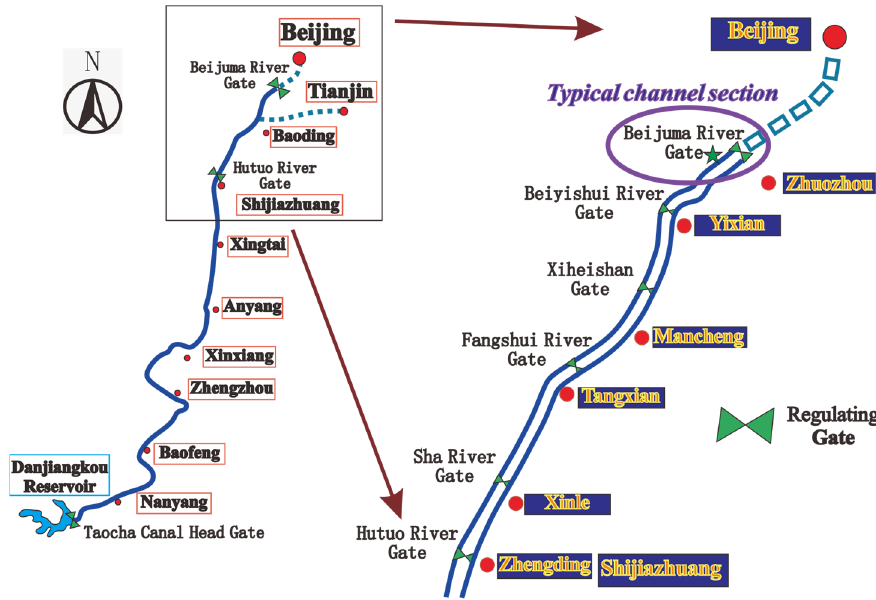
Figure 1. Overview of study area.